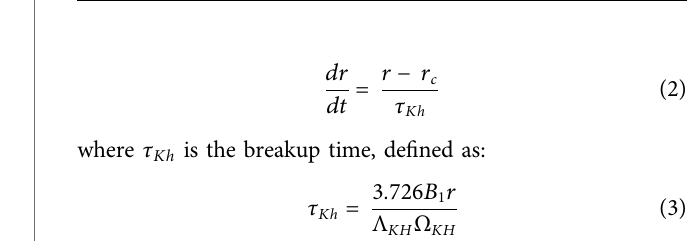
FIGURE 3 | Magni fi ed front view of the stepped holes of the Spray G injector.